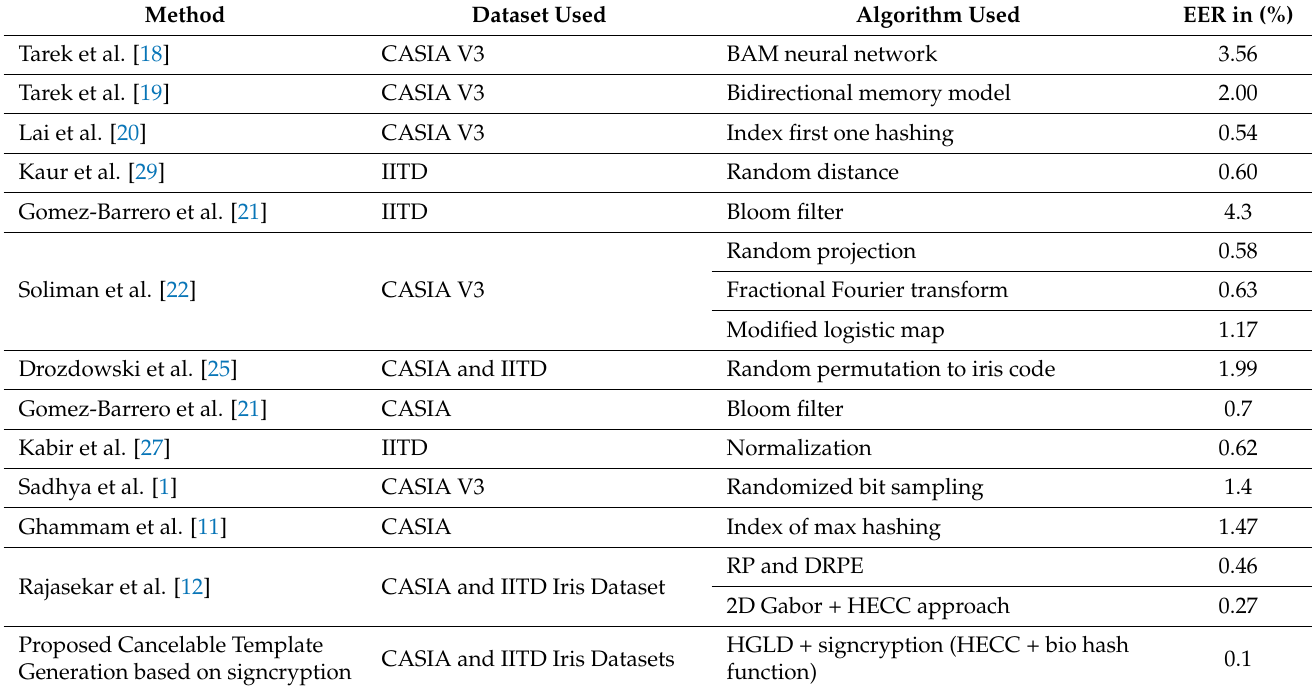
Table 3. Comparison of the EER and the accuracy of cancelable approaches (HGLD, signcryption) with the existing schemes.